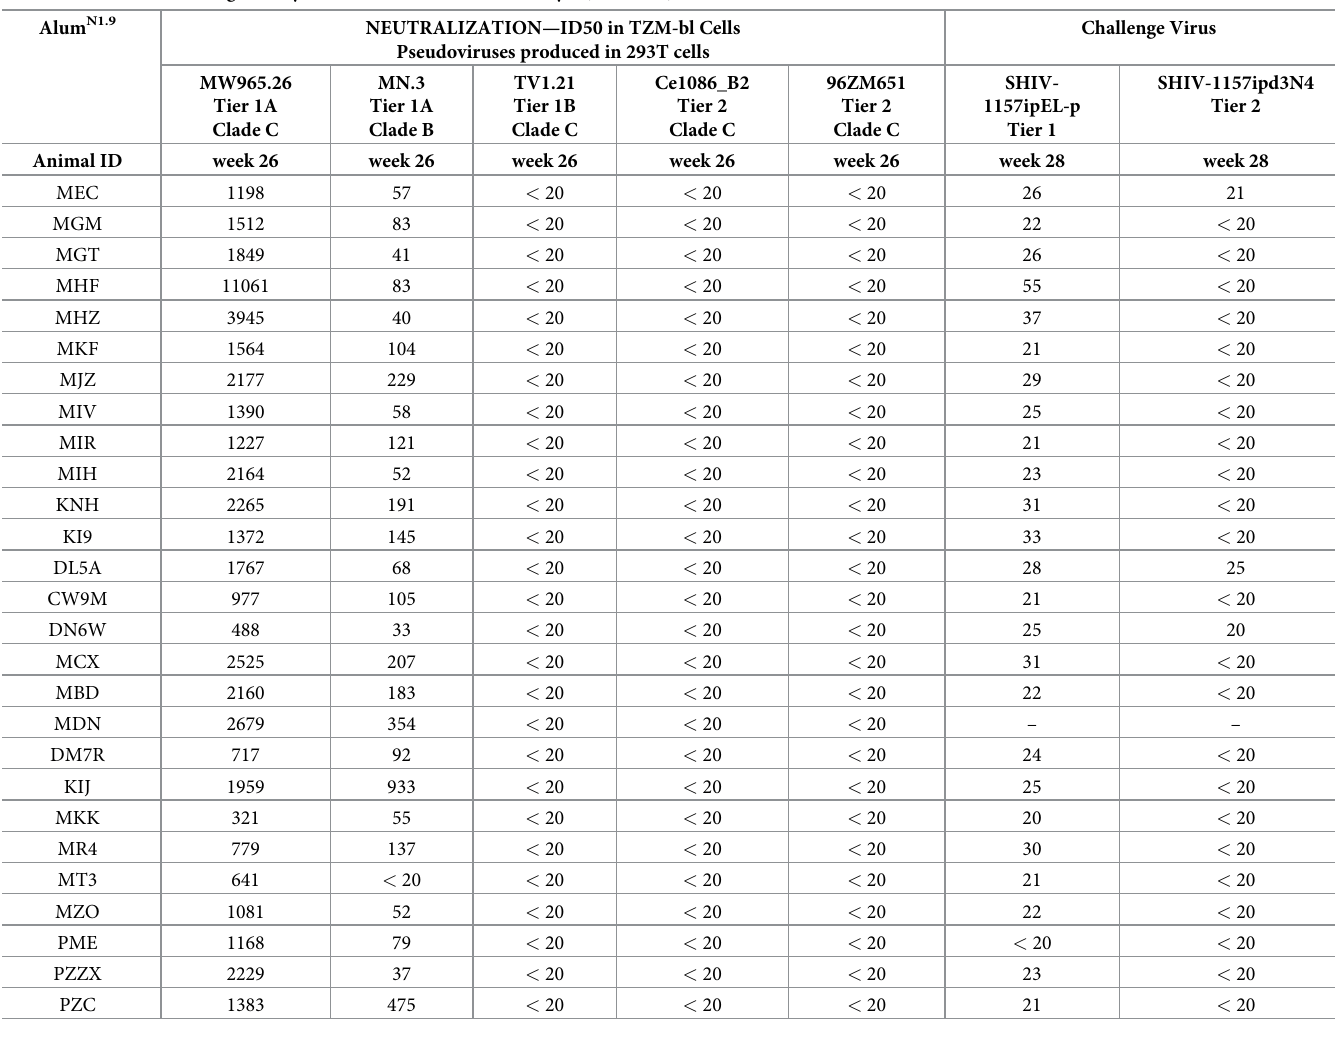
Table 3. Serum neutralizing activity in animals immunized in Study 1 (Alum N1.9 ). Alum N1.9 NEUTRALIZATION—ID50 in TZM-bl Cells Pseudoviruses produced in 293T